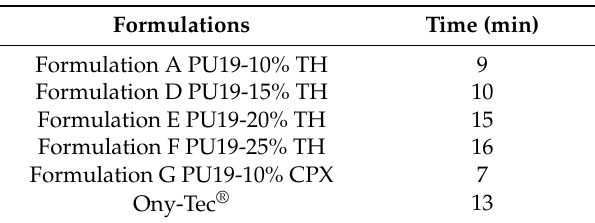
Table 4. Nail lacquer’s drying time ( n =